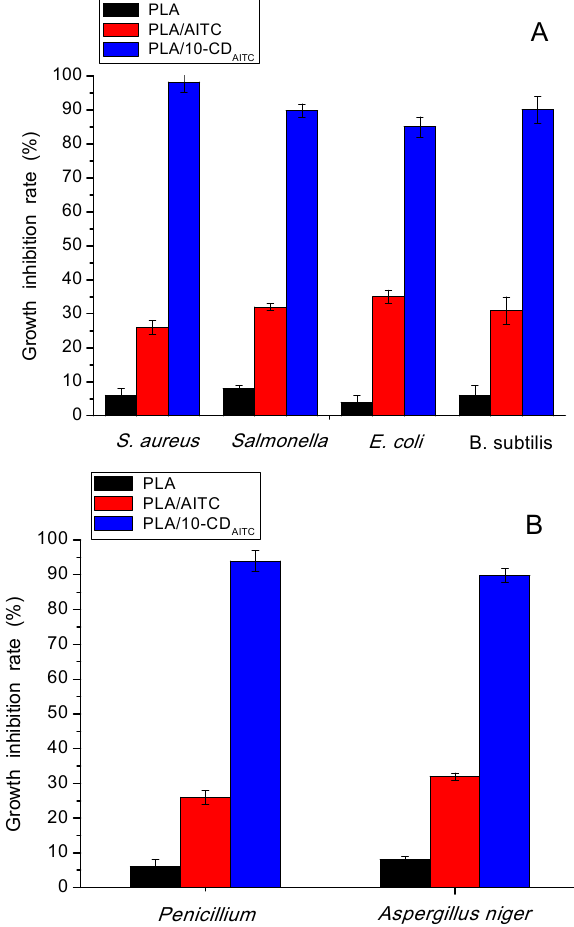
Figure 4. Growth inhibition rate (%) of bacteria ( A ) ( S. aureus , Salmonella , E. coli , B. subtilis ) and mold ( B ) ( Penicillium , Aspergillus niger ) in PLA film, PLA film with 10% β -CD/AITC, and PLA film with allyl isothiocyanate (AITC).